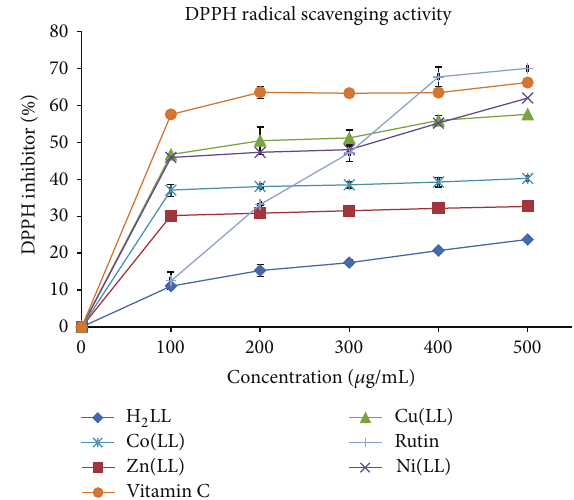
Figure 5: DPPH scavenging activity of H 2 LL Schiff bases and their metal